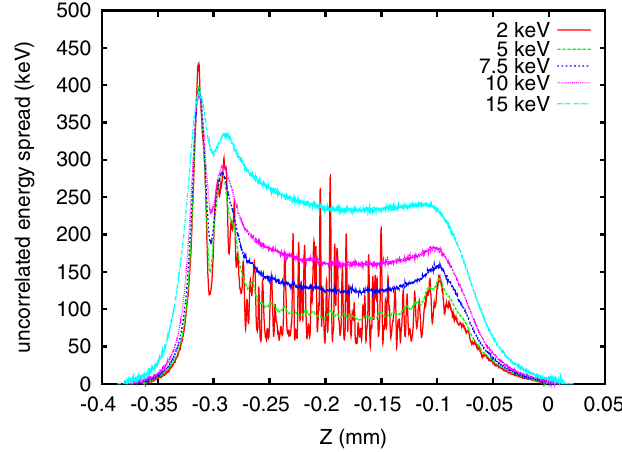
FIG. 10. (Color) Final uncorrelated energy spread distribution resulting from an initial square root parabolic current profile with initial 2, 5, 7.5, 10, and 15 keV uncorrelated